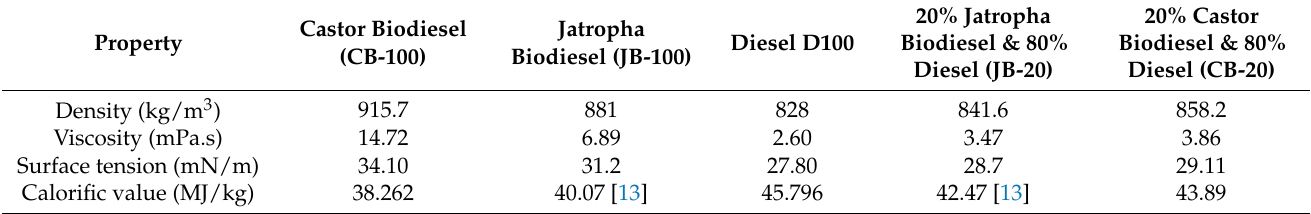
Table 2. Fuel properties of diesel, jatropha and castor